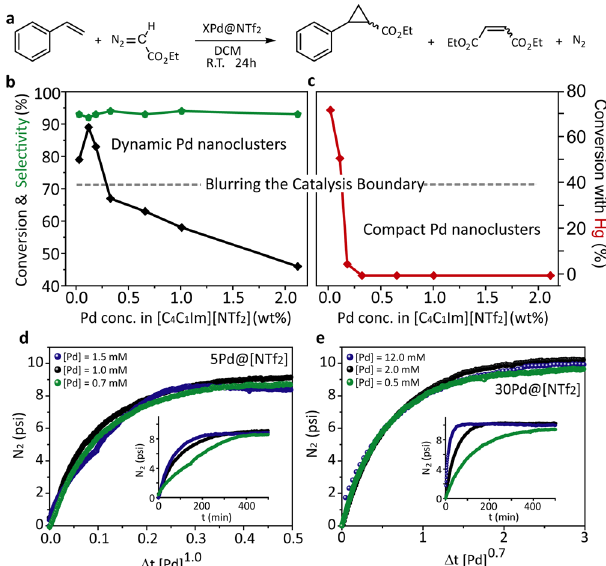
Fig. 3 Cyclopropanation of styrene. a Reaction scheme of the cyclopropanation of styrene as a model reaction with X Pd@ Y . A complete substrate scope can be found in Supplementary Notes 1. b Conversion (black) and selectivity (green) with varying Pd contents in [C 4 C 1 Im][NTf 2 ] determined after 24 h; reaction conditions: diazoethyl acetate (1 mmol), styrene (5 mmol), X Pd@[NTf 2 ] (5 mol%, based on Pd) and DCM (5 mL) at room temperature. c Conversion with varying Pd contents in [C 4 C 1 Im] [NTf 2 ] and the presence of Hg, reaction conditions as in b with Hg. b , c Dashed line represents the boundary in between pseudo-homogeneous and classical heterogeneous catalysts. d , e represent the time normalised analysis of the N 2 release (which is coupled to the overall catalytic transformation) with varying catalyst concentrations. The catalyst order is represented as the magnitude of the [Pd] concentration and the original data can be found as insets in d and e , respectively. A catalyst order of 1 is found for 5Pd@[NTf 2 ] ( d ) and an order of 0.7 is found for 30 Pd@[NTf 2 ] ( e ). Reaction conditions in d , e : 1 mmol ethyl diazoacetate, 5 mmol styrene, 5 mL DCM at 35 °C with varying concentrations of Pd but constant concentration of [C 4 C 1 Im][NTf 2